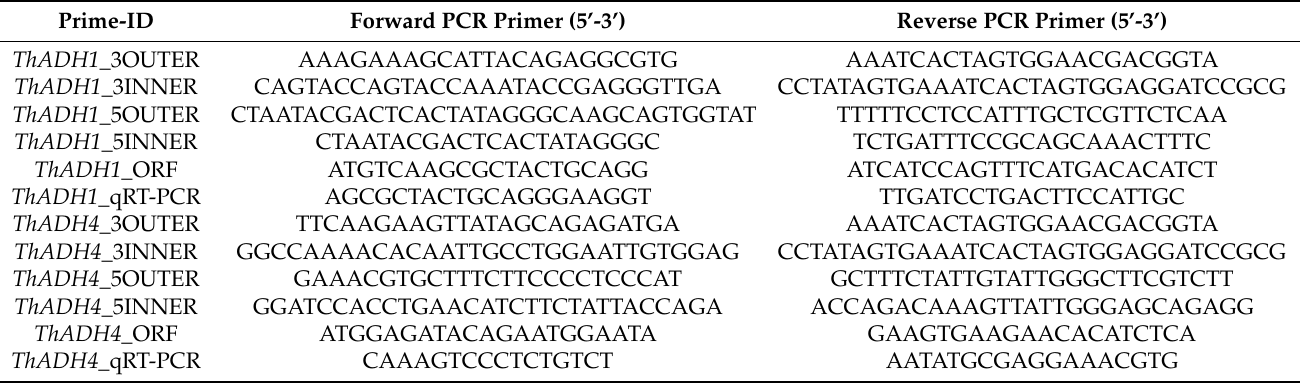
Table 1. Primer sequences of the genes for rapid amplification of cDNA ends (RACE), open reading frame (ORF) and real-time quantitative polymerase chain reaction